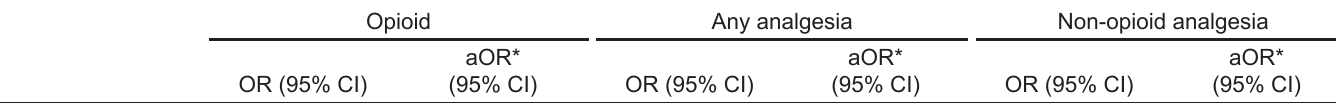
Table 2. Unadjusted and adjusted association of patient race/ethnicity and analgesia administration with subgroup analyses. Opioid Any analgesia Non-opioid